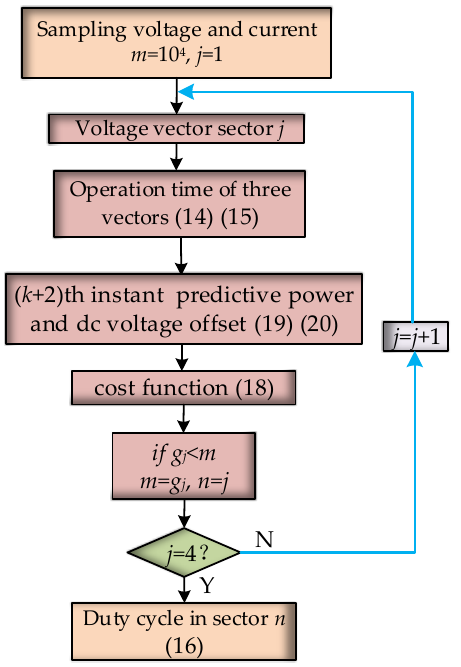
Figure 5. Flow diagram of constant-frequency-MPC (CF-MPC) for fault-tolerant BVSC.